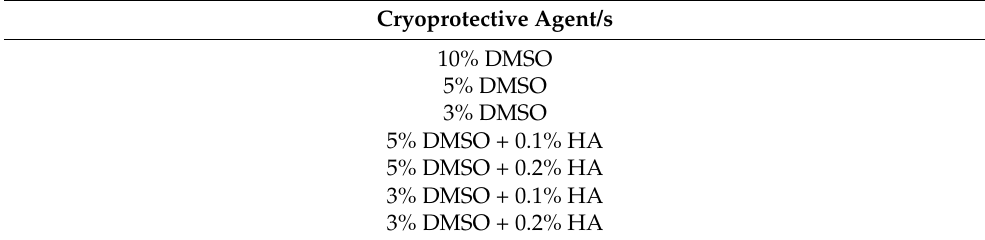
Table 1. Overview of CPA specifications used during uncontrolled-rate freezing of DPSCs.